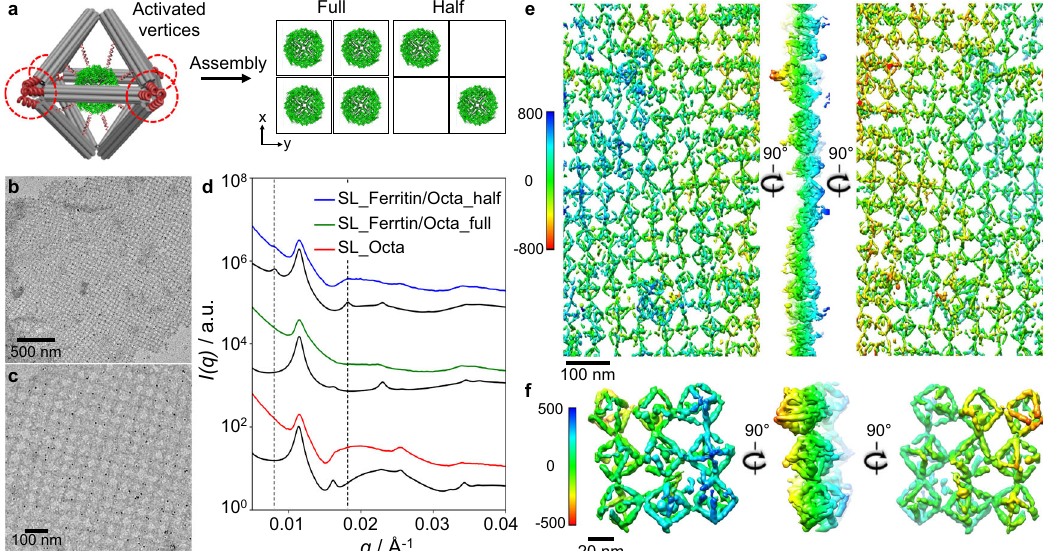
Fig. 3 Ferritin assembly in ordered 2D single-layered array. a Schematics showing a projected view of 2D single-layered (SL) protein/Octa lattices, where the in-plane vertices were encoded by one set of complementary DNA pairs (i.e., a one-color system). Ferritin was placed at the center of Octa for assembly into a fully integrated lattice, and a half- fi lled lattice by alternating the ferritin/Octa and empty Octa in the same lattice. b , c Negative-stained TEM images of SL ferritin/ Octa lattices, where c shows a magni fi ed image of the lattice. d SAXS data and analyses of SL ferritin/Octa lattices, in which the experimental data (colored lines) and the corresponding simulated results (black lines) were presented for Octa and the different types of ferritin/Octa lattices (measured and calculated intensity pro fi les were shifted vertically for clarity). e , f Cryo-ET 3D reconstruction of an SL ferritin/Octa lattice, where a series of tilted cryo-EM images were aligned and reconstructed in 3D without averaging using the IMOD and IPET software. The 3D density maps showed an overlay of the encapsulated ferritin with the SL lattice in one structure, indicating the overall conformation of the ferritin/Octa lattice. ( e : selected lattice area and f : the representative views). The ferritin positions in f were indicated by the black arrows in Supplementary Fig. 22d. The color bars indicate Z height (unit: